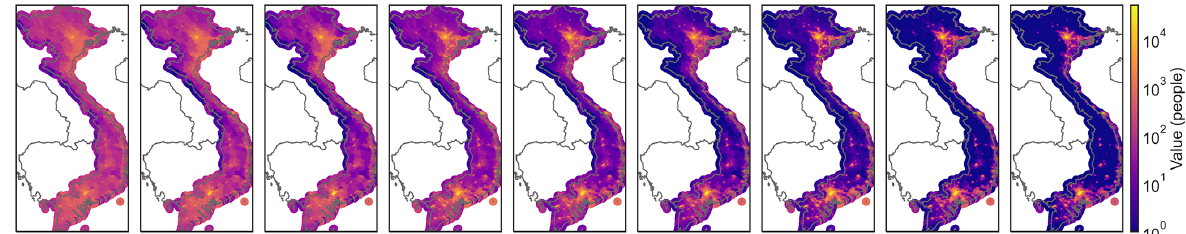
Figure D1. Population distribution obtained by combining population density layer and nightlight satellite imagery (cf. Litpop method, Eberenz et al., 2020) for all combinations of the nightlight and population exponents m and n considered in the uncertainty analysis (cf. Table 1). From left to right, m,n = (0, 0.75); (0, 1); (0, 1.25); (0.5, 0.75); (0.5, 1); (0.5, 1.25); (1, 0.75); (1, 1); (1, 1.25), with (0, 1) the original case study value.